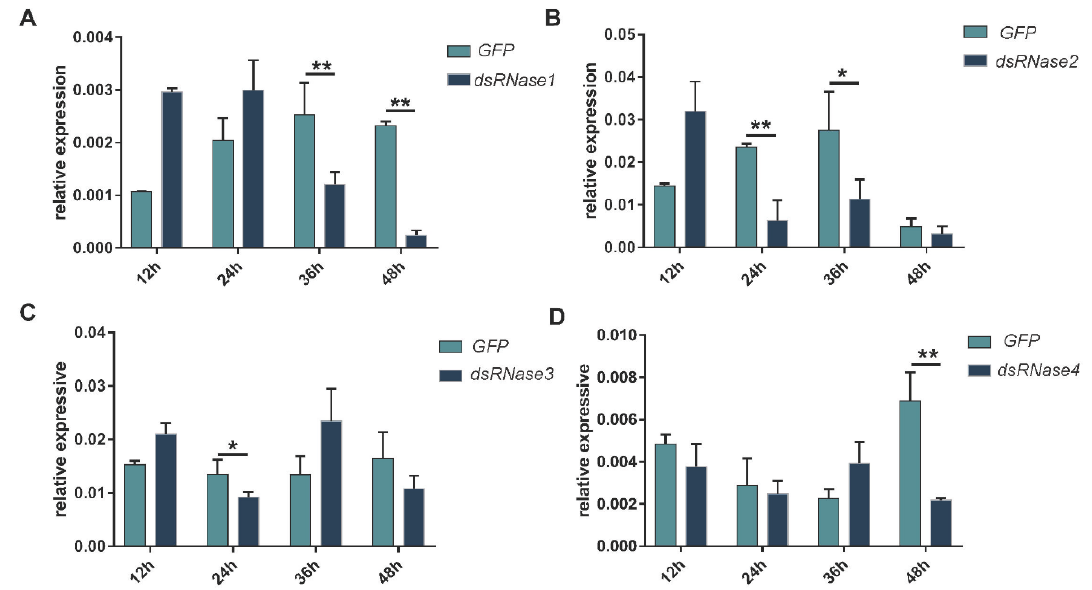
Figure 4. Effects of dsRNA injection on the expression levels of PxdsRNases . The fourth instar larvae were injected with 600 ng of different dsPxdsRNases or dsGFP, and the transcription levels of PxdsRNase genes were detected by RT-qPCR at different times. EF1 was used as the reference gene for normalization. Statistical analyses were performed using one-way ANOVA followed by the Turkey test. ( A ) PxdsRNase1 ; ( B ) PxdsRNase2 ; ( C ) PxdsRNase3 ; ( D ) PxdsRNase4 . (*, p < 0.05; **, p < 0.01).